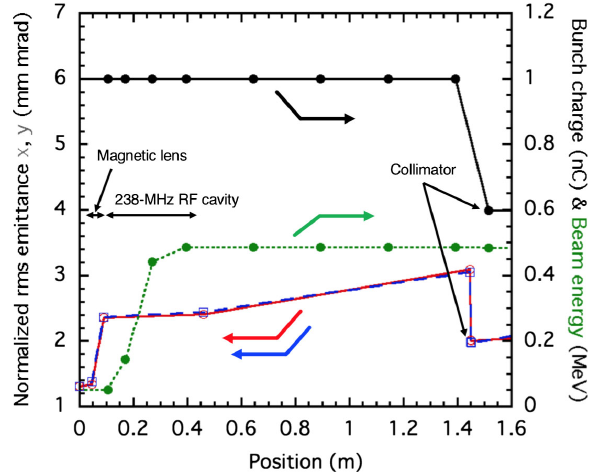
FIG. 6. The normalized emittance, bunch charge, and beam energy along the rf gun system obtained with PARMELA simu- lation. The origin of the horizontal axis represents the exit of the 50-kV thermionic gun. The red solid and blue dashed lines represent evolutions of the horizontal and vertical projected normalized emittance (left axis), respectively. The black solid and green dotted lines represent evolutions of the bunch charge and beam energy (right axis), respectively. 238-MHz rf cavity with PARMELA simulation. Figure 6 shows the simulation results with the space charge effect included. The solenoid field by the magnetic lens is adjusted so that the normalized emittance at the 238-MHz rf cavity is minimized without beam loss. The normalized emittance in the magnetic lens increases up to 2.5 mm mrad with a bunch charge of 1 nC due to the space charge effect. The beam collimator is installed 1-m downstream from the 238-MHz rf cavity exit. The normalized emit- tance at this position increases to 3.1 mm mrad. The beam collimator can scrape the outer part of the beam to provide